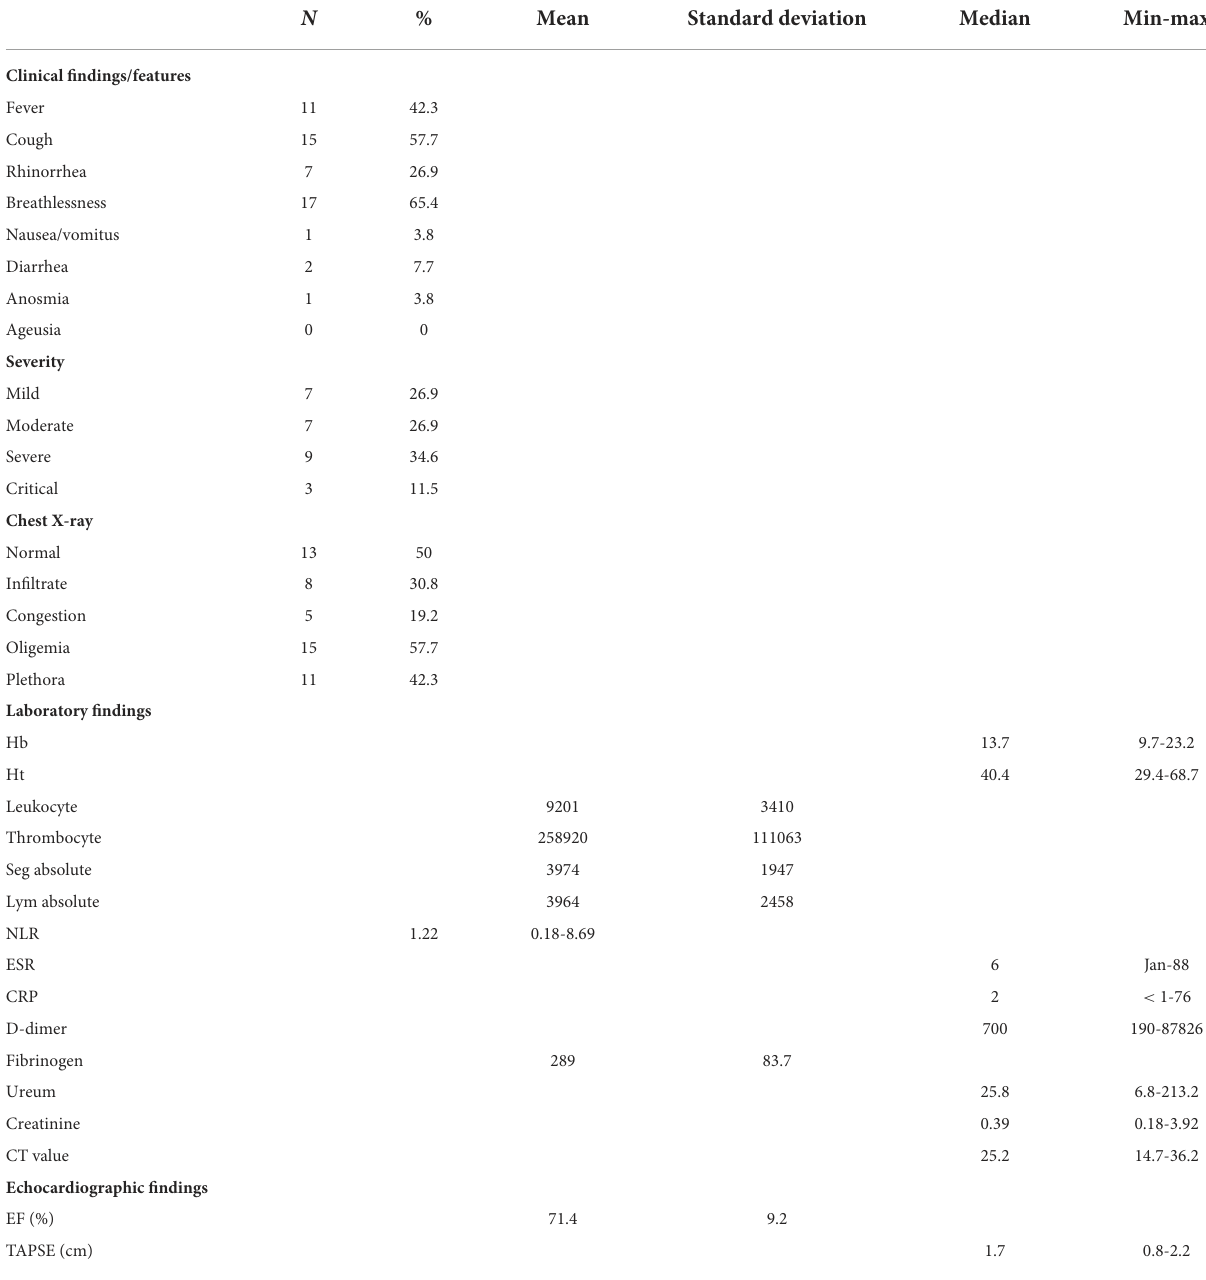
TABLE 2 Clinical manifestation and supportive examination findings. N Mean Standard deviation Median